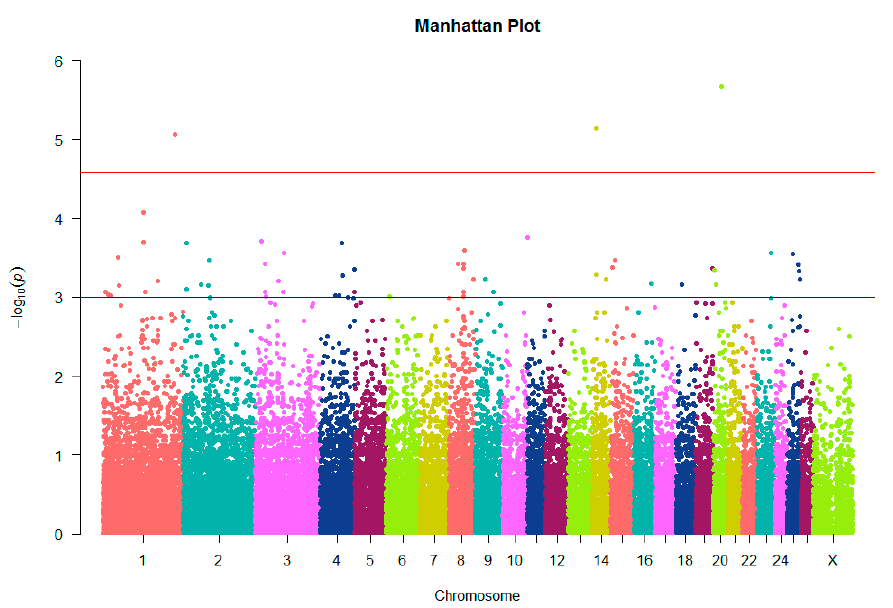
Figure 2. Manhattan plot showing single-nucleotide polymorphisms (SNPs) associated with litter size on the ovine chromosome. The red line corresponds to the 5% chromosome-wide significance threshold using a Bonferroni correction (2.6 × 10 − 5 ). The blue line corresponds to a suggestive chromosome-wide threshold of 10 − 3 .